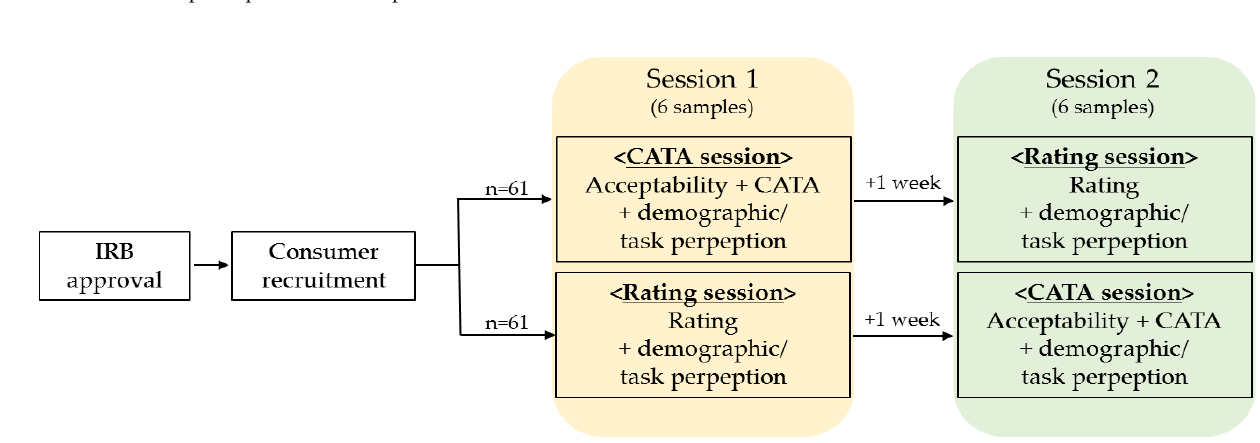
Figure 1. Flowchart of wine perception consumer test.